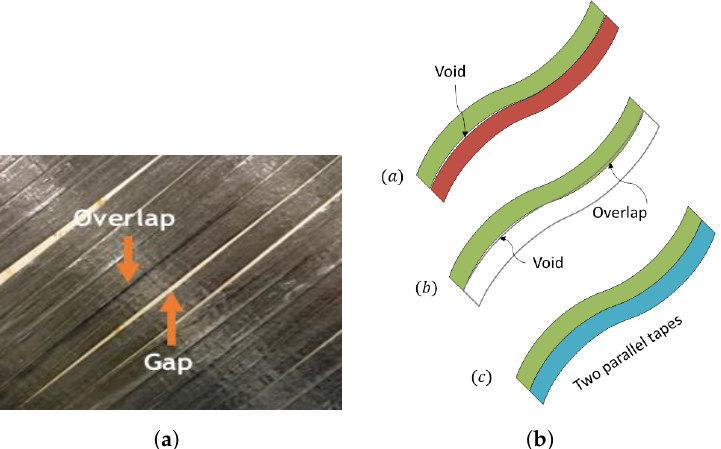
Figure 3. Tapes gap/overlap generated in VAT laminates during AFP manufacturing. ( a ) gap/overlap representation [34]; ( b ) description of gap/overlap.